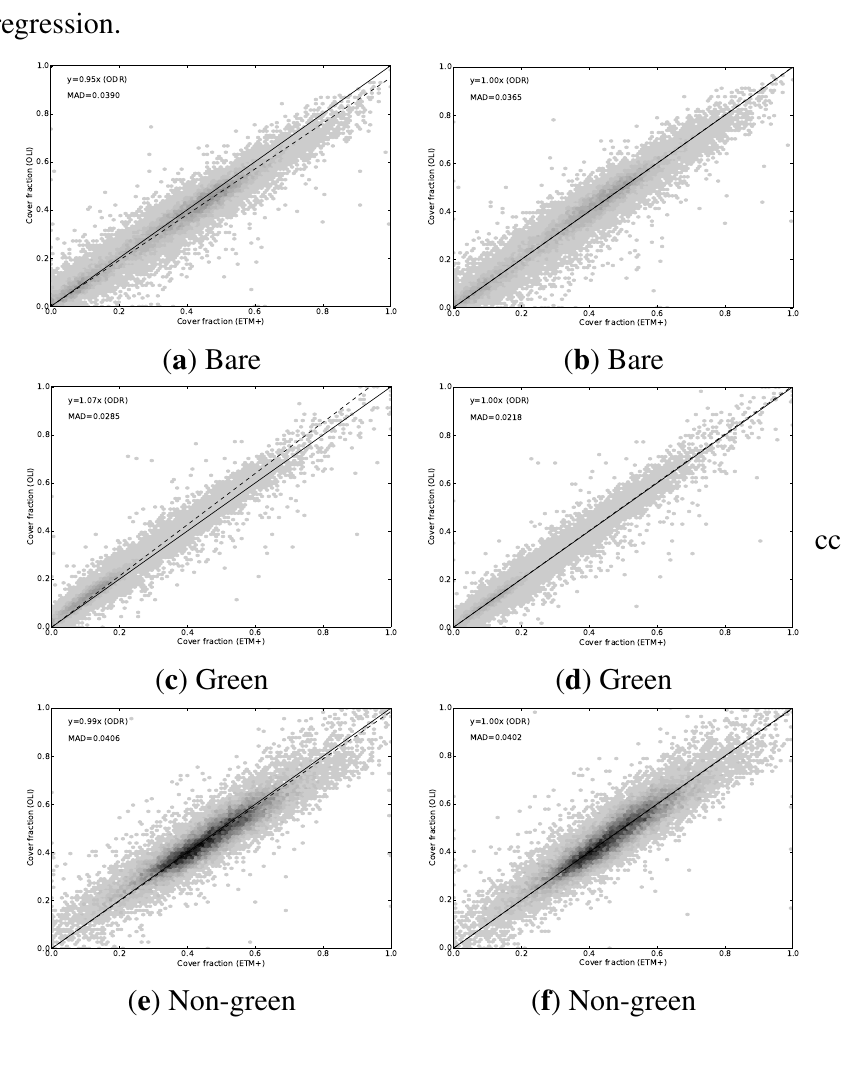
Table 2. Regression coefficients for surface reflectance. For each band, ETM+ reflectance is predicted from OLI reflectance as ρ